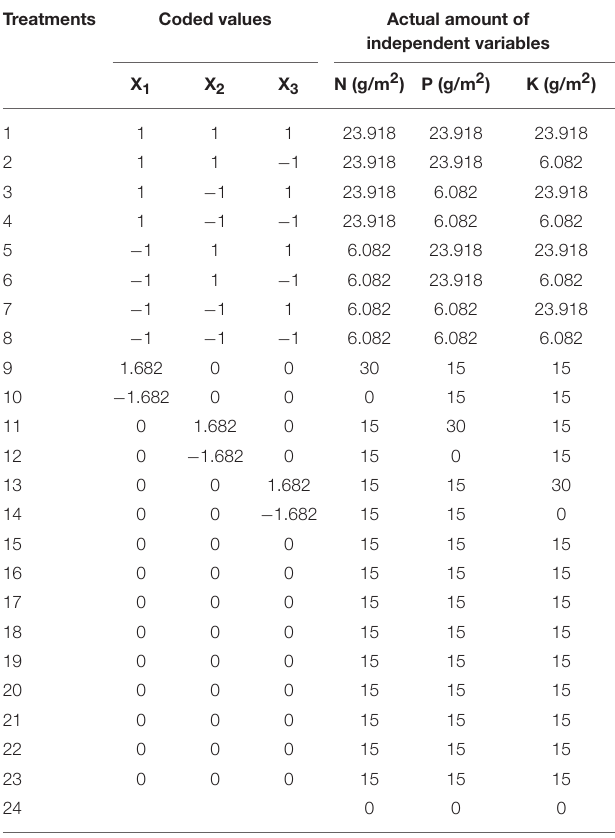
Treatments 1 through 24 represent the total number of experimental plots. X 1 , X 2 , and X 3 represent coded values for N, P, and K respectively.